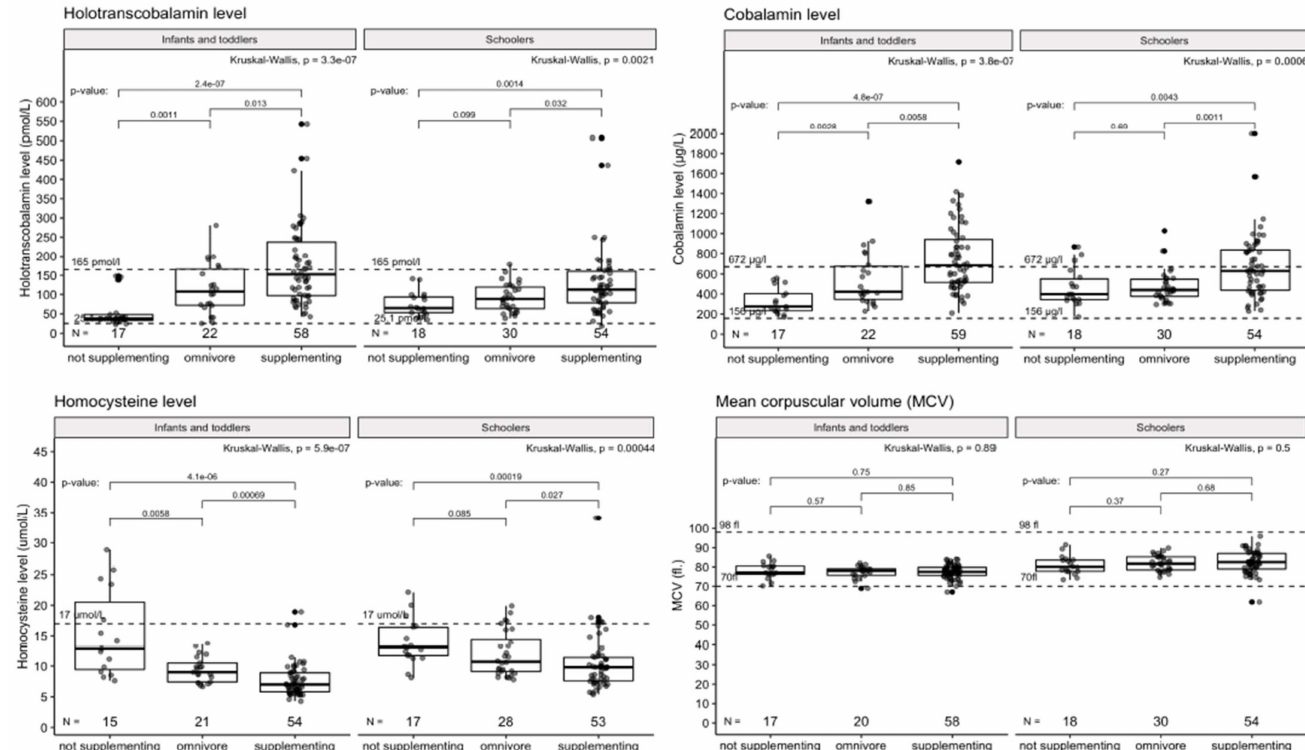
Figure 3. Laboratory markers of vitamin B12 metabolism according to supplement use in the VG/VN group. Cross-sectional comparison of 69 VN, 79 VG, and 52 OM, divided by age group. MCV (fl) = mean corpuscular volume. Dashed lines indicated the reference interval of the